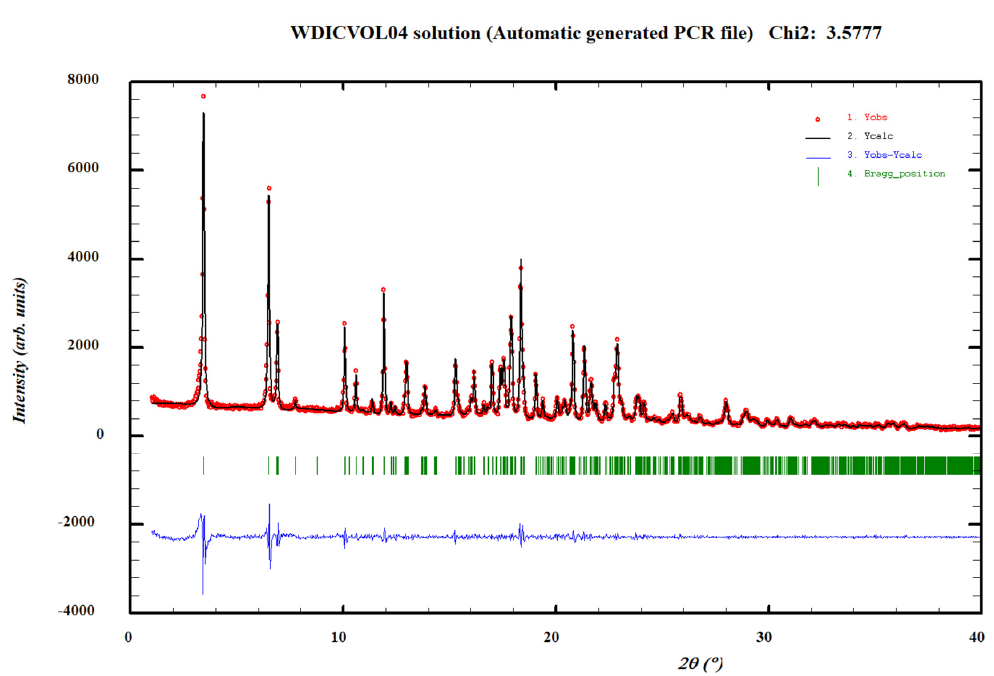
Figure 6. Pattern matching refinement of the AD–hydroquinone cocrystal. Agreement factors: R wp : 7.68%; R exp : 4.06% (Chi-square: 3.58). Experimental XRPD profile (red marks), calculated XRPD profile (black solid line) and the difference between them (blue, line). Tick marks correspond to peak positions (|, in green).